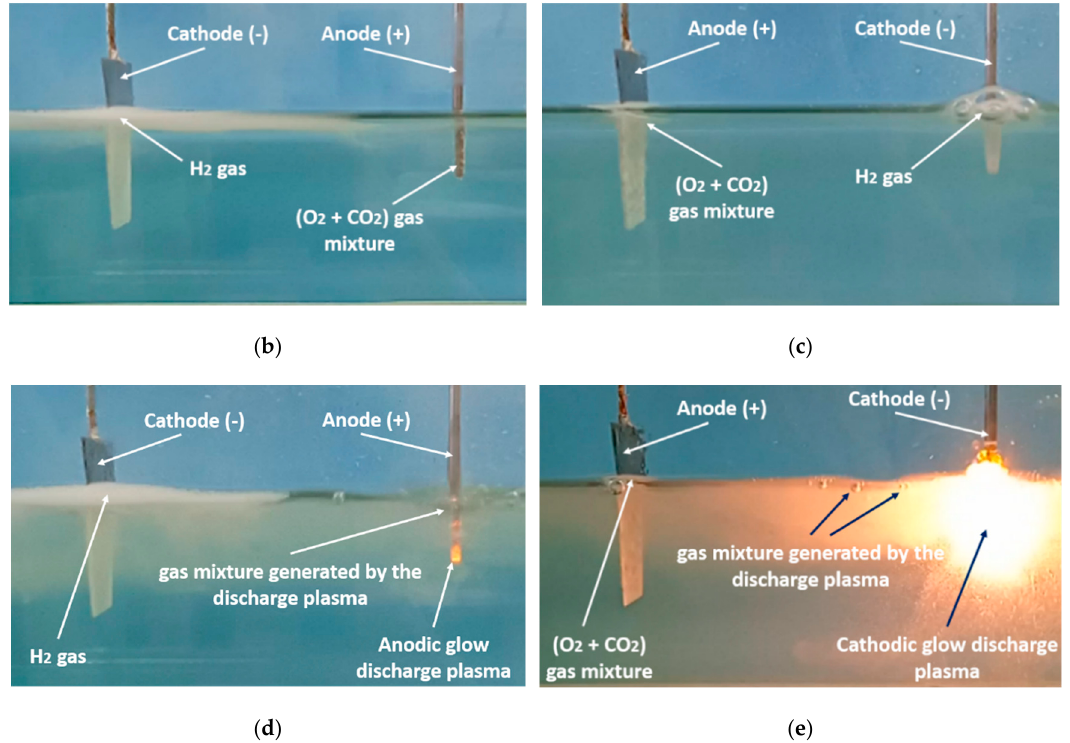
Figure 4. Transformation of the electrolysis from the Faradaic form into the anodic and cathodic regimes of PDSE with increasing applied voltage: ( a ) the electrolytic cell before applying DC voltage, ( b ) Faradaic electrolysis at an applied voltage of 20 V (tungsten rod served as an anode), ( c ) Faradaic electrolysis at an applied voltage of 20 V (tungsten rod served as a cathode), ( d ) the anodic regime of PDSE at the applied voltage of 130 V (discharge onset voltage was 60 V), ( e ) the cathodic regime of PDSE at the applied voltage of 120 V (discharge onset voltage was 52 V). The electrolytic solution was 10 wt% Na 2 CO 3 water solution at the initial temperature of 22 °C and atmospheric pressure. The electrodes: a stainless-steel plate with a thickness of 0.4 mm and 2 cm × 2cm active surface area exposed to the electrolytic solution and a tungsten rod with a diameter of 2 mm. The active length of the stainless-steel plate was 2 cm. The active length of the tungsten rod was 1 cm. The ratio of the active surface area of the smaller electrode and that of the larger electrode is about 1/12 [39].